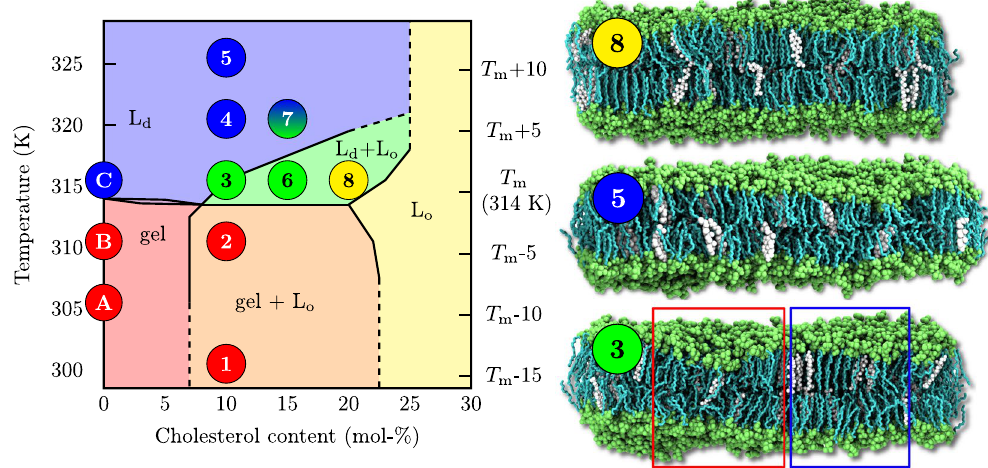
Figure 1. Left: Phase diagram with phase boundary lines as suggested by Vist and Davis 13 . Liquid–liquid coexistence is expected in the L d + L o regime (green). The L o , L d , gel and gel + L o regions are coloured in yellow, blue, red and orange, respectively. The diagram is shifted upward by 4 K so that the main transition temperature T m agrees with that of non-deuterated DPPC. The locations of the simulated systems, also listed in Table S1, are shown by numbers (DPPC–cholesterol) and letters (pure DPPC). Their colours indicate their phases determined from our analyses. Systems 3, 6, and 7 show heterogeneous behaviour. Right: Snapshots of selected systems labelled by the points in the phase diagram: (8) Chol20 316 (L o phase), (5) Chol10 326 (L d phase), (3) Chol10 316 (ordered/disordered/hexagonal), DPPC is shown in cyan and lime (chains and other parts) and cholesterol in white. Water, ions, and lipid chain hydrogens are omitted for clarity. Red and blue boxes highlight disordered and ordered regions,